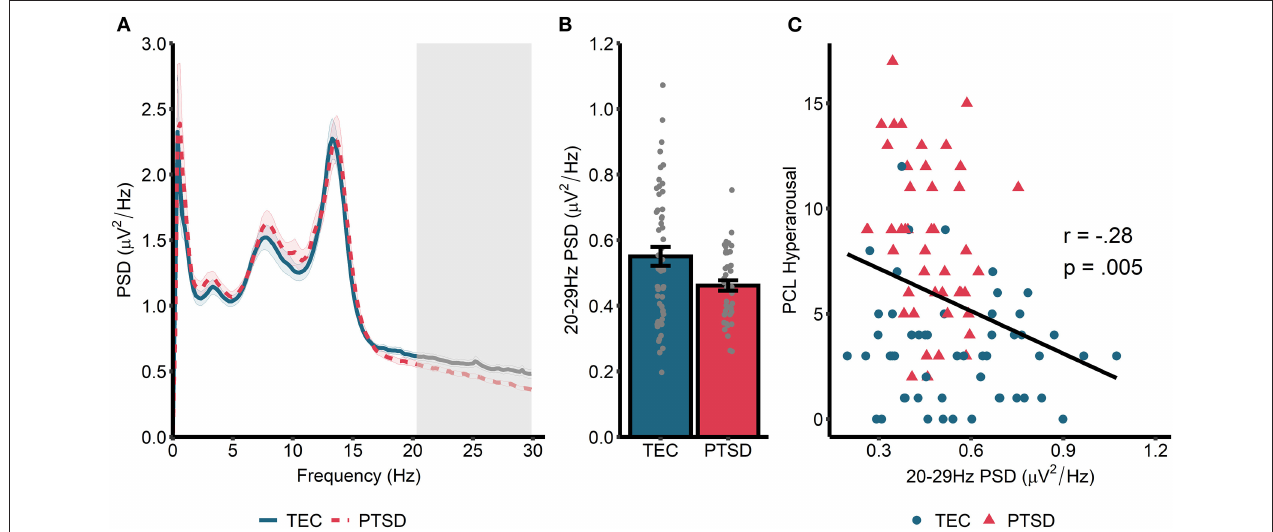
FIGURE 1 | Power spectral density during NREM sleep. (A) 0–30Hz power spectrum during NREM sleep. Note that PSD at each frequency is relative to the average PSD in the 0–30Hz range. Shaded area around lines denotes the standard error. Gray box marks frequencies showing significant group differences following cluster correction. (B) PSD averaged across frequencies in the significant cluster. (C) Correlation between spectral power (averaged across frequencies in the significant cluster in A ) and symptoms of